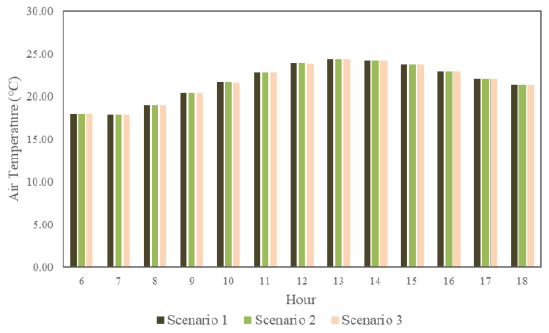
Figure 8. Hourly trend of simulated air temperature at 1.8m for the three scenarios in Lower Session Road, Baguio City. Similar trend was observed with peak air temperature at 13:00.